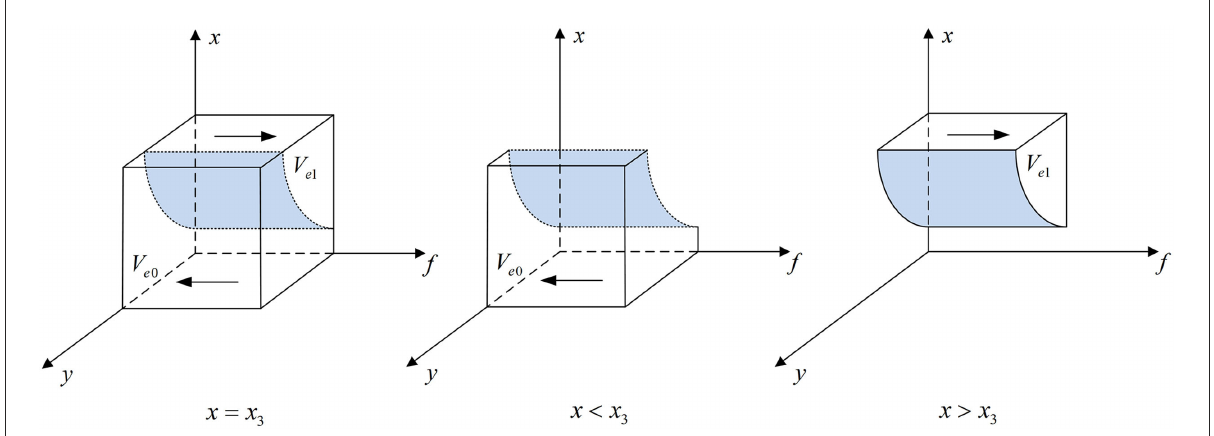
FIGURE5 Phase diagram of pharmaceutical e-commerce companies’ strategic choice. Figure is the phase diagram that shows the evolutionary trend of pharmaceutical e-commerce companies’ strategy obtained by calculating the response function of the probability of pharmaceutical e-commerce companies choosing the “inspection” strategy.